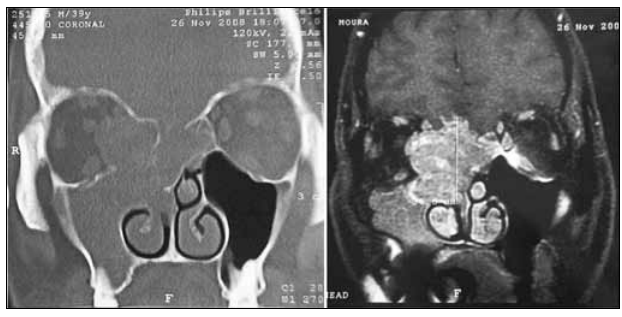
Figure 3. Preoperative CT and MRI of patient IGM, stage Kadish C and Dulguerov T3n0. Source: own data.